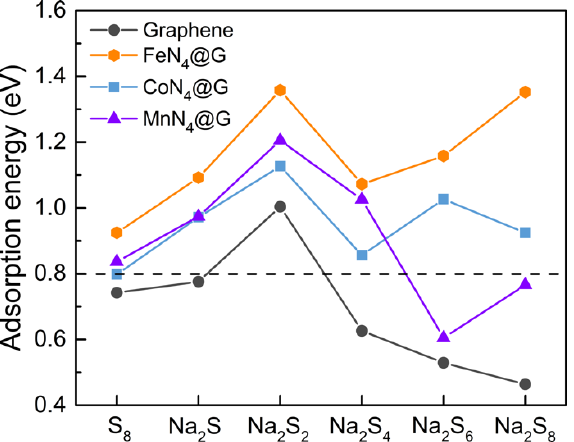
Figure 5. The computed adsorption energy profile of cyclo-S 8 and Na 2 S n (n = 1, 2, 4, 6, and 8) species after absorbing on pristine and transition metal-N 4 @graphene (metal = Fe, Co, and Mn) surface, respectively. The dashed line represents the critical energy of weak physical adsorption.